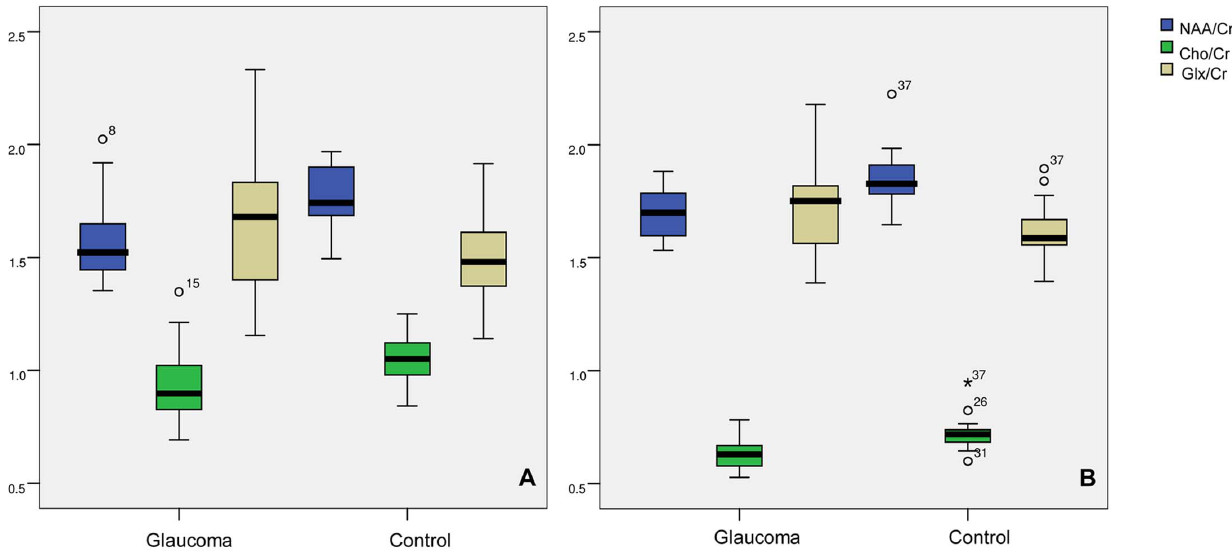
Figure 4. Metabolite concentrations. Figure 4A displayed the averaged concentrations ratios of NAA, Cho and Glx to Cr for the glaucoma group and the controls in the GCTs. Figure 4B displayed the averaged concentrations ratios in the striate area. The Independent-Samples T Test between the two groups showed significant differences for the NAA and Cho concentrations but no difference for the Glx concentration.